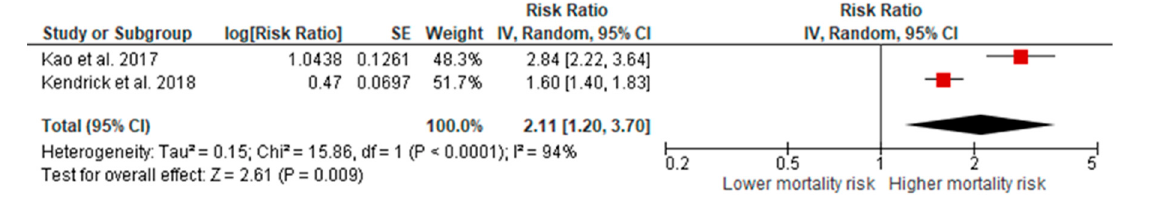
Figure 5. All-cause mortality risk in AKI patients with dementia .